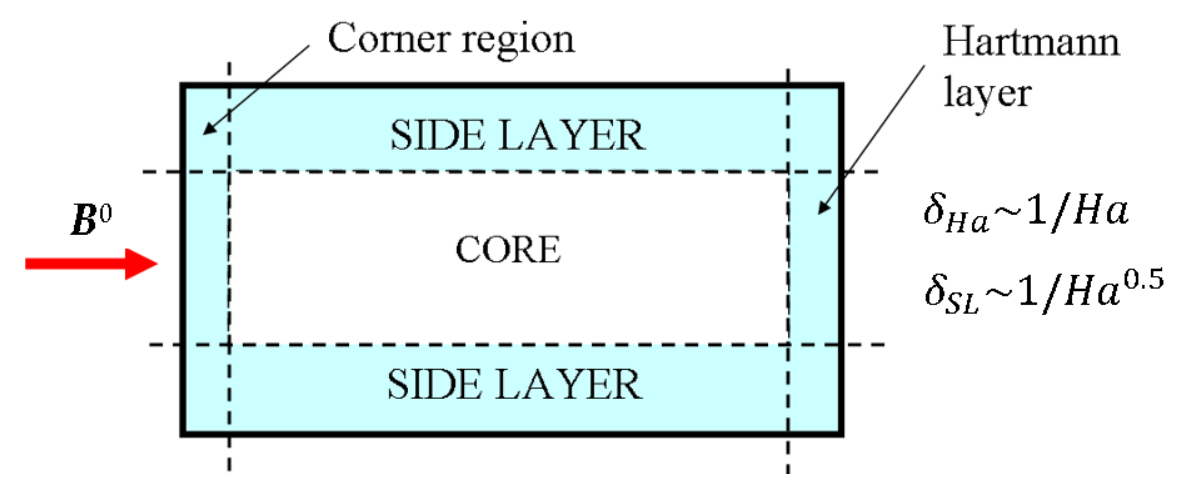
Figure 15. Asymptotic structure of a dully developed MHD flow in a rectangular duct with either conducting or non- conducting walls in a transverse magnetic field.